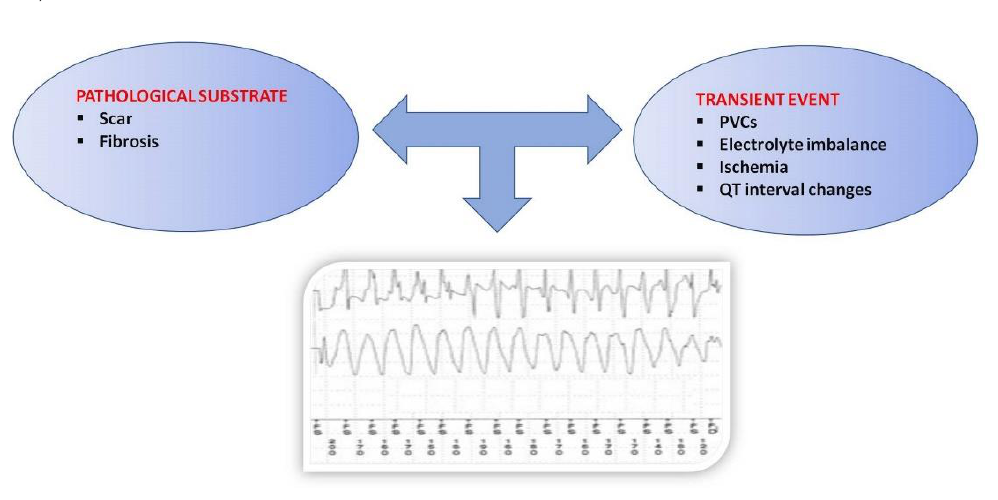
Figure 1. Anatomic substrate and pathophysiology of sudden cardiac death in heart failure reduced ejection fraction. PVCs: Premature ventricular complex; QT: QT interval